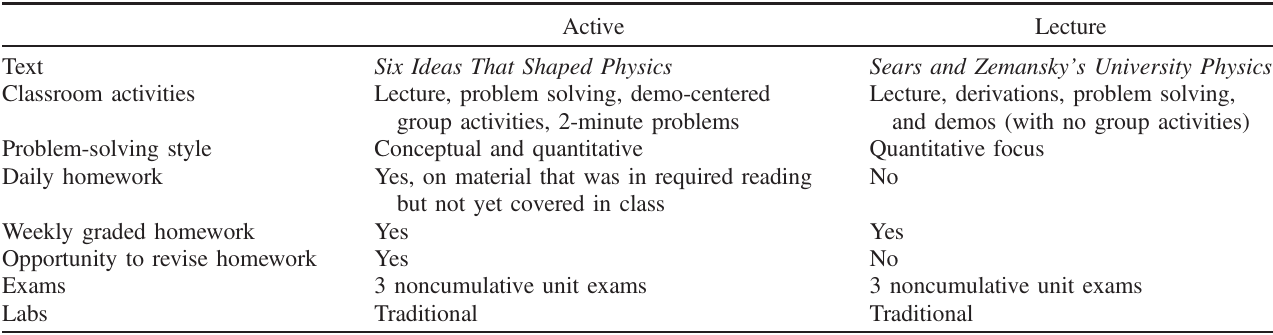
TABLE III. Summary of similarities and differences between Active Physics and traditional-lecture